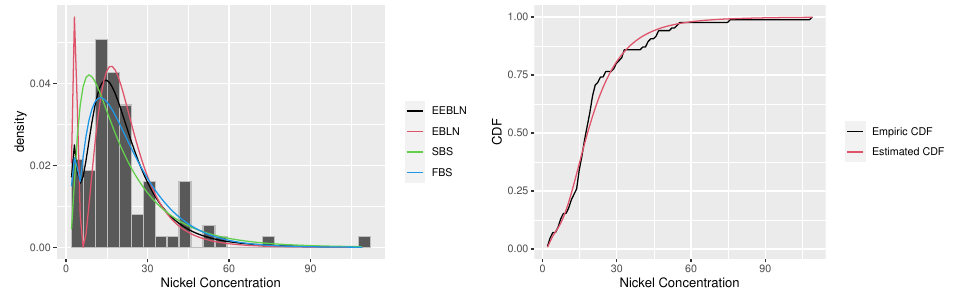
Figure 5. ( Left ) Fits of the EEBLN, EBLN, SBS, and FBS distributions for the nickel data. ( Right ) Empirical and estimated cdf of the EEBLN distribution.